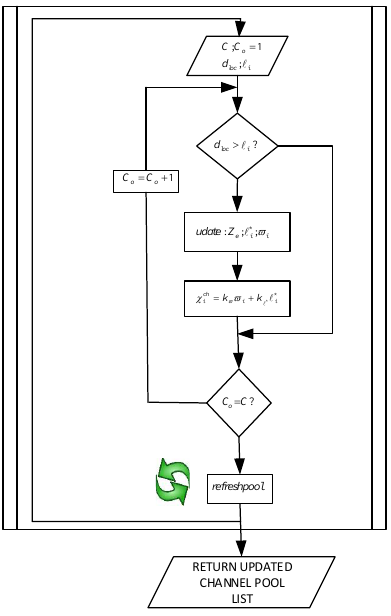
Figure 2. MROR channel pool update